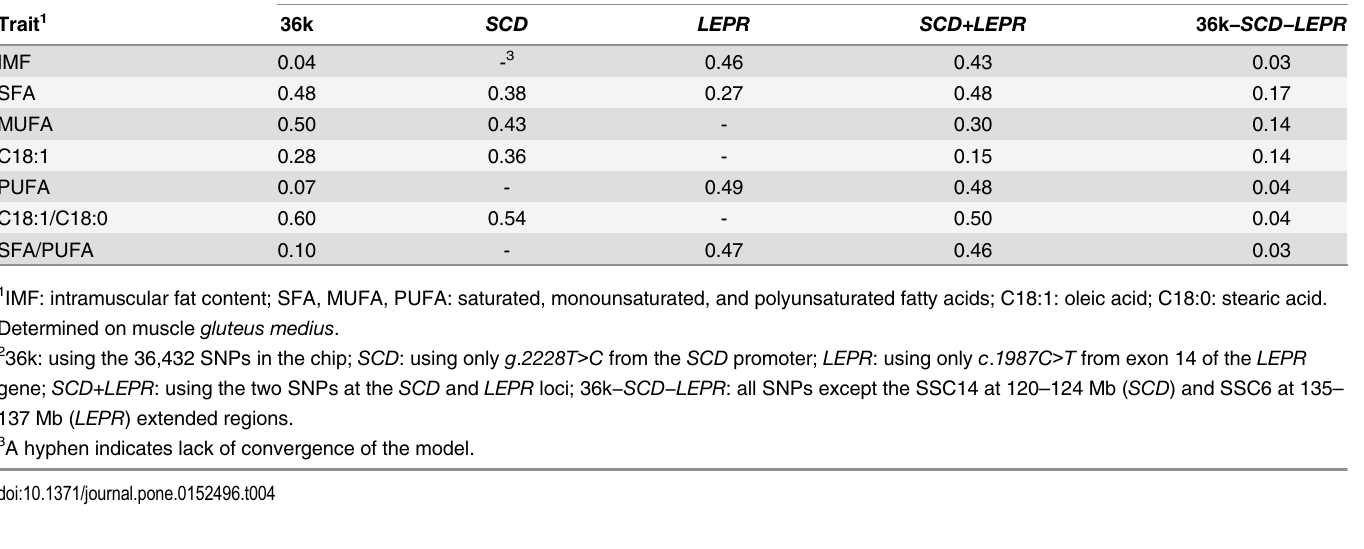
experiments using Iberian × Landrace crossbreds [13,14]. In these studies, neither the SCD nor the LEPR loci were detected. This result can be expected for the SCD locus, because there is no evidence that the investigated SCD polymorphism segregates in Iberian, Landrace, or any breed other than Duroc and Large White [12,46]. The LEPR c . 1987C > T polymorphism, though, was first described in an Iberian × Landrace intercross [20], but posterior studies have used mostly Duroc, either purebred [36,37] or crossbred with Landrace × Yorkshire [35,38] or Iberian [34]. Table 4. Correlations between genomic estimated breeding values and adjusted phenotypes of the 2009-born pigs using the 2002-born as training set and using different sets of SNPs for both training and prediction. SNPs used for training and prediction 2 Trait